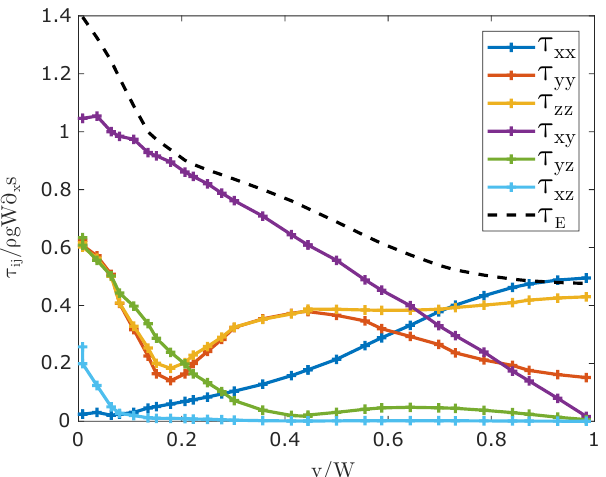
Figure 5. Across-flow transects of depth-averaged non-dimensional stress from the full-Stokes viscoelastic model (Sect. 4) for experi- ment n3xyz. Profiles are taken 100km downstream of the GL at high tide ( w a = 2m). The stress scale is given by τ ij /ρgW∂ x s , and the length scale by y/W